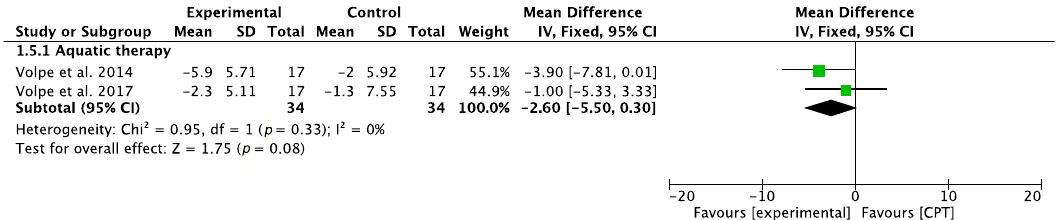
Figure 6. Forest plot for fall-related self-efficacy measured by FES. Green block indicates the weight assigned to the study and the horizontal line depicts the confidence interval. Black rhombus shows the overall result. The bold words highlight the total/subtotal values and the different modalities of therapies used in the interventions.